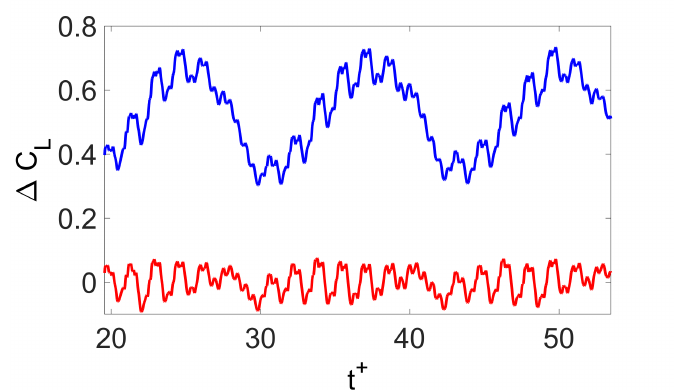
Figure 5. A comparison of the standard convolution integral (blue line), and the convolution integral after high-pass filtering (red line) for a sinusoidally varying burst amplitude at k =